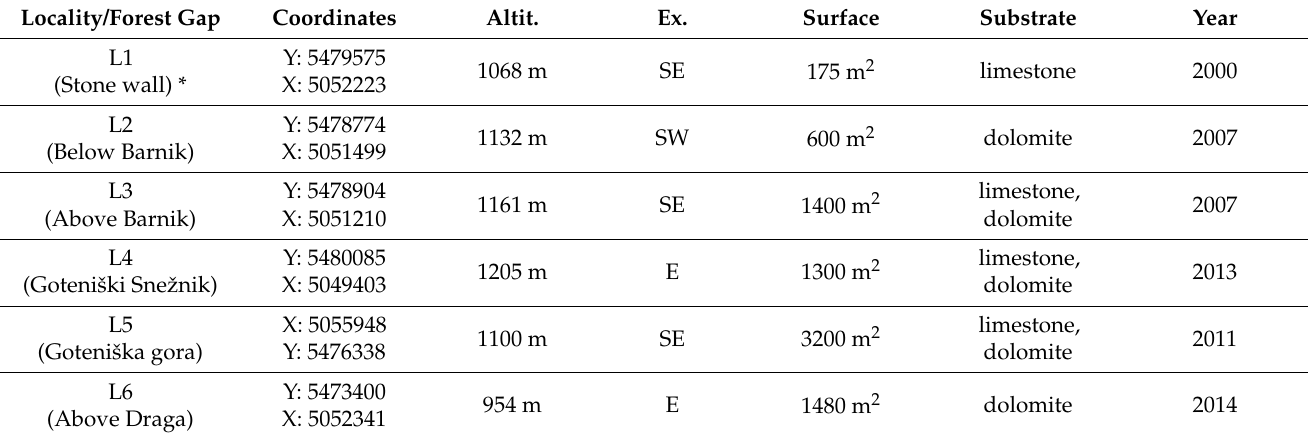
Table 1. Forest gaps and their features (coordinates, UTM quadrant, altitude, aspect, substrate, soil, year of origin). The location marked * is control site with juvenile phase of beech